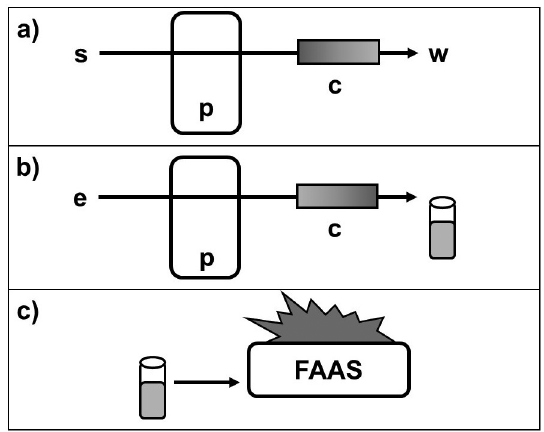
Figure 1 - Diagram of the preconcentration procedure used for determination of cadmium by FAAS. s. sample; e. Eluent; p. Peristaltic pump; c. AT-XAD-2 minicolumn; W. waste. (a) preconcentration stage, (b) elution stage, (c) stage of metal